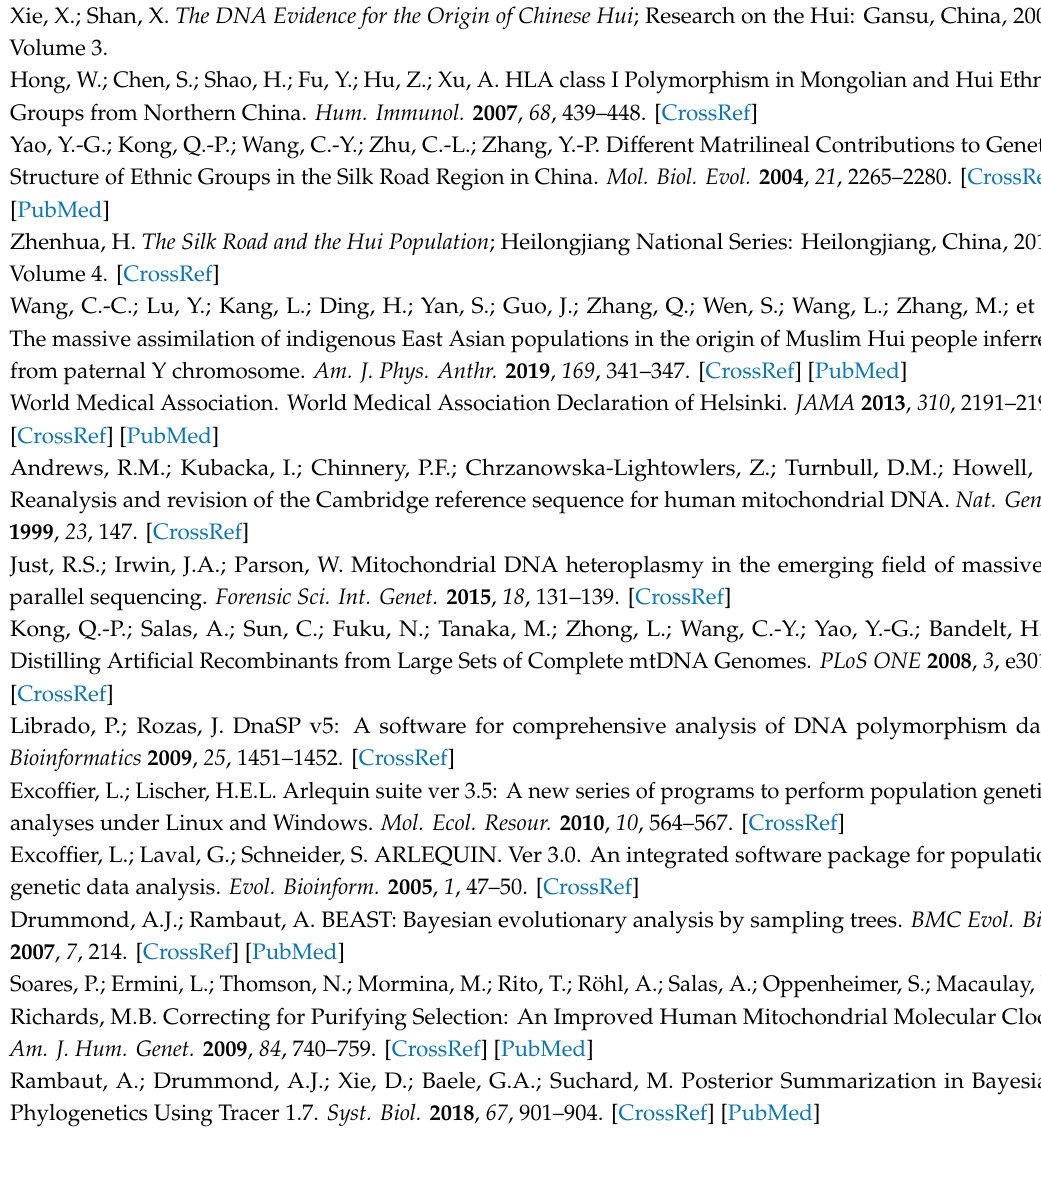
Figure S1: The sequencing performance of the MultipSeqTm AImumiCap mtDNA Whole Genome Panel assessed from the read depth of 98 Hui individuals; Figure S2: Mismatch distribution of Hui group with a unimodal pattern; Figure S3: A scree plot represented the variance of each principal component captured; Figure S4: A world map plotted all the populations in this study and was colored by language families; Figure S5: The networks of East Asia-specific haplogroups except the D4 haplogroup; Table S1: The comparison populations and the corresponding references involved in this study; Table S2: Variants and haplogroup information of the 98 Hui